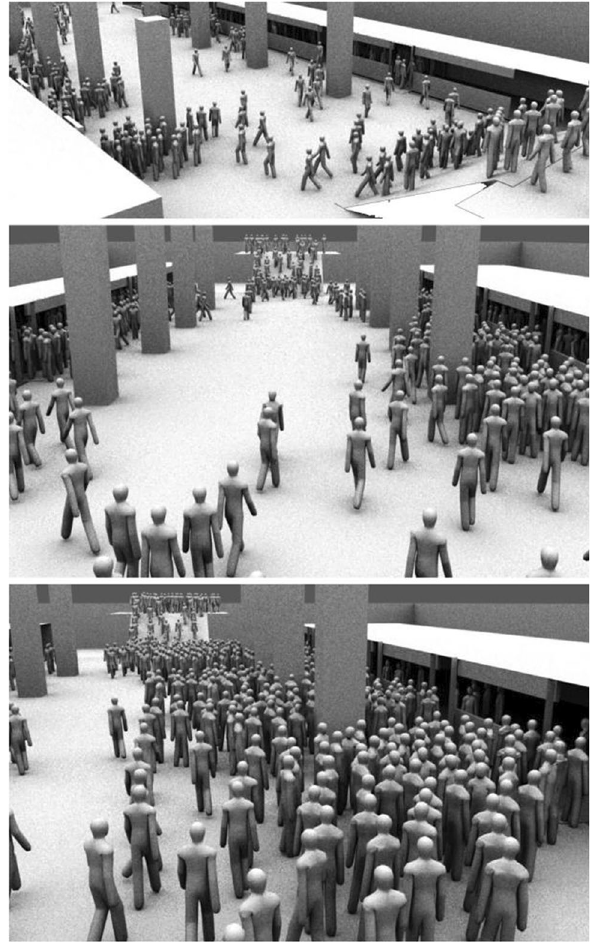
Fig. 2 A large number of agents are boarding in simulated Beijing subway station. Agents interact with each other and the arriving train. By Ming